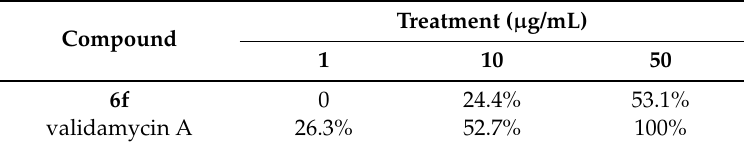
Table 2. The inhibition rate of 6f on the germination of sclerotia of R. solani a